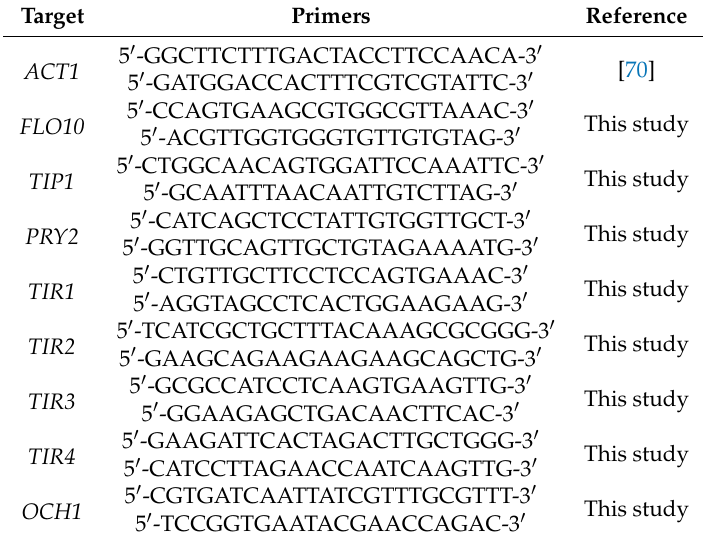
Table 2. qPCR primer sets used in this